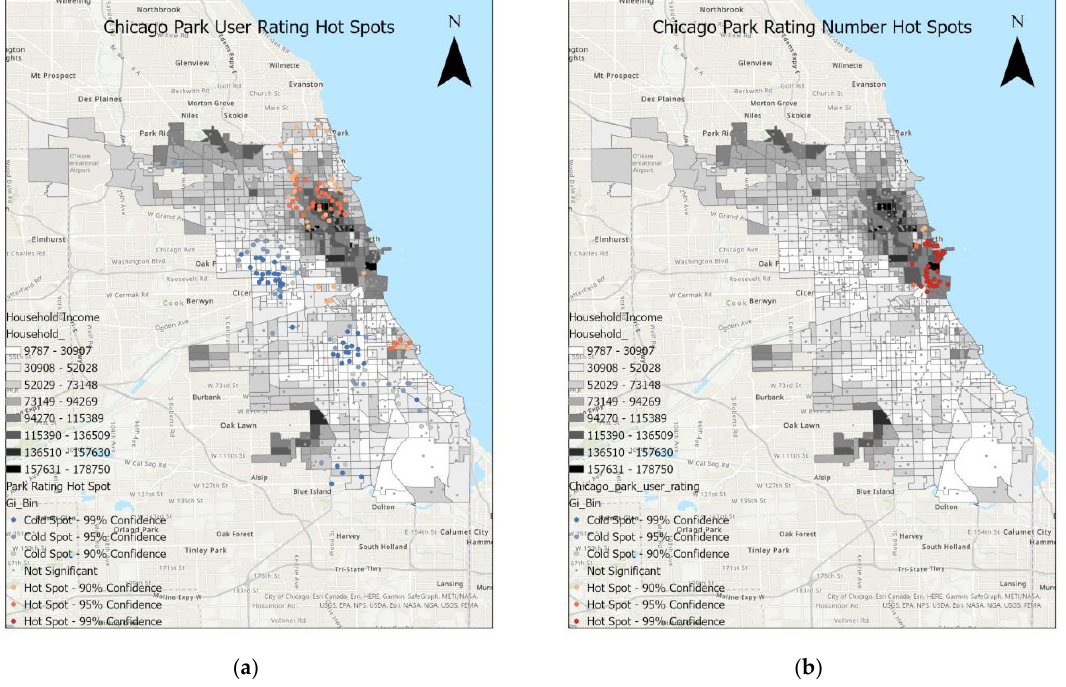
Figure 6. The hot and cold spots detected through the Getis–Ord Gi* statistic with respect to the park rating scores ( a ) and rating numbers ( b ). The household income of census tract in 2019 is col- ored by grayscale.